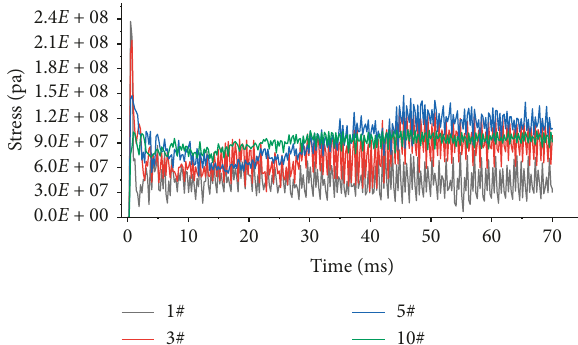
Figure 5: Stress-time curves of the representative elements on the rack face ( α � 10 ° , H � 10mm, and V � 1.36m/s).